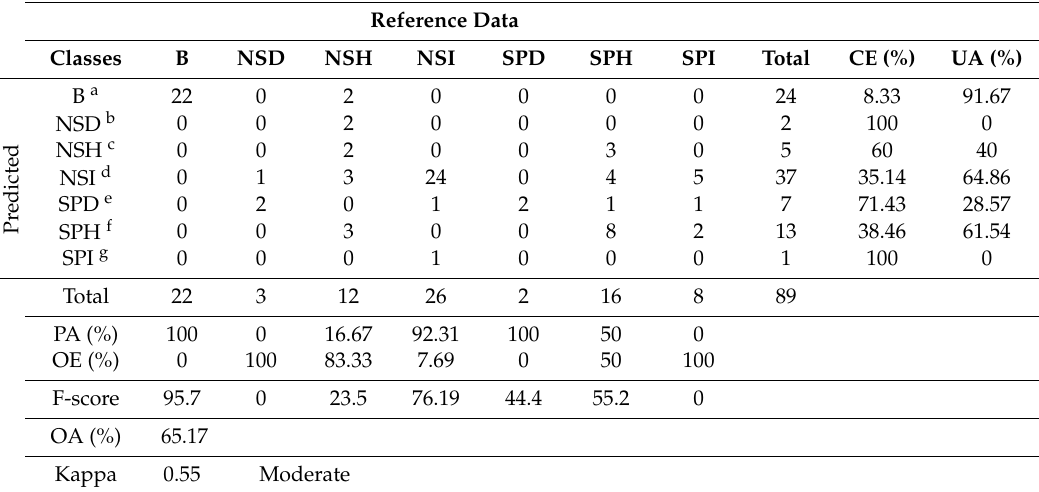
Table 7. Classification summary table and confusion matrix including combined tree species and health status derived from the support vector machine (SVM) analysis using VI